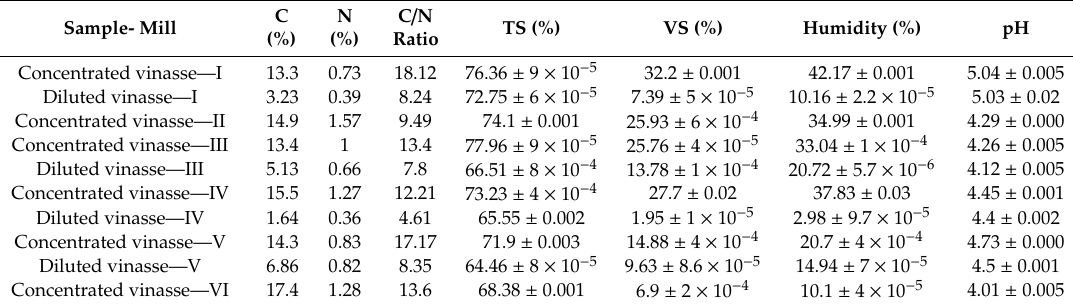
Table 4. Physiochemical characterization of